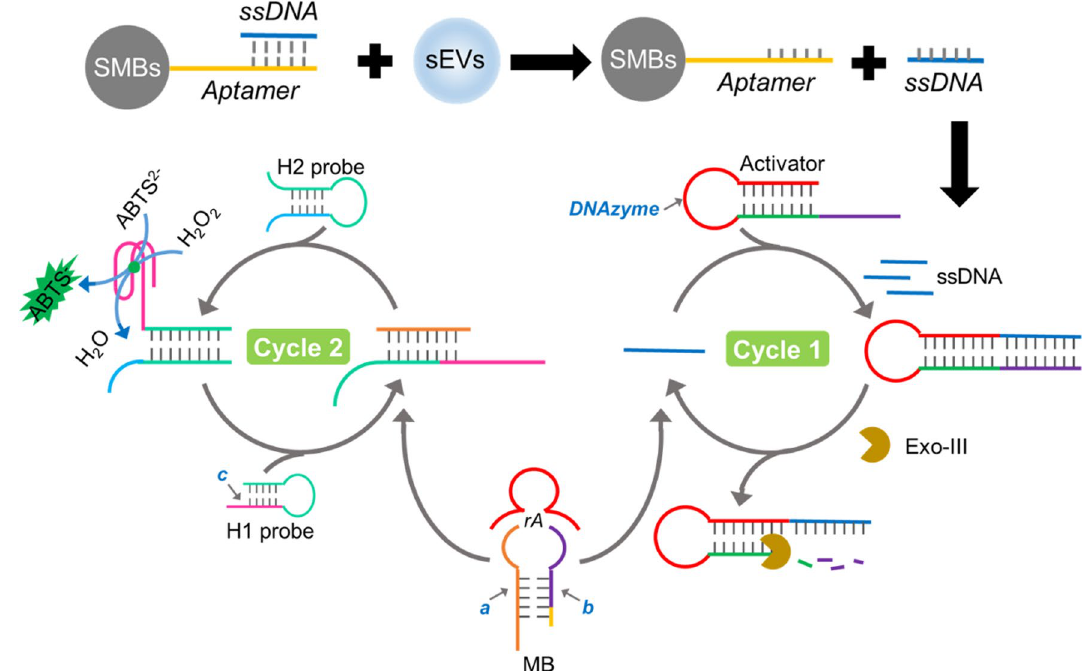
Fig. 1 The working mechanism of the established approach for DNA targets